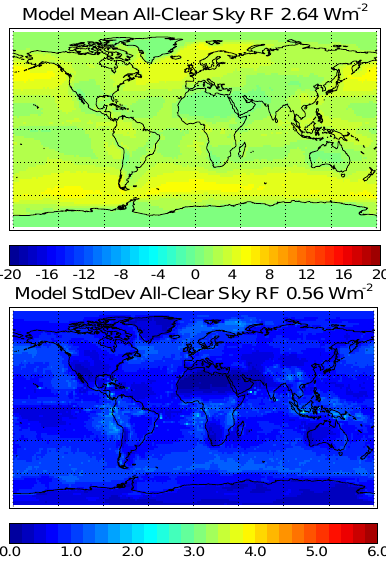
Fig. 18. Annual multi-model mean and standard deviation dif- ference between all-sky and clear-sky top-of-atmosphere radia- tive forcing between experiments FIX3 and FIX0 with AOD=0.2 and AOD=0.0 distributed over the lowest two kilometers, hold- ing SSA=0.8 and ANG=1.0 constant. Model fields have been remapped to a resolution of 1.875 ◦ × 1.875 ◦